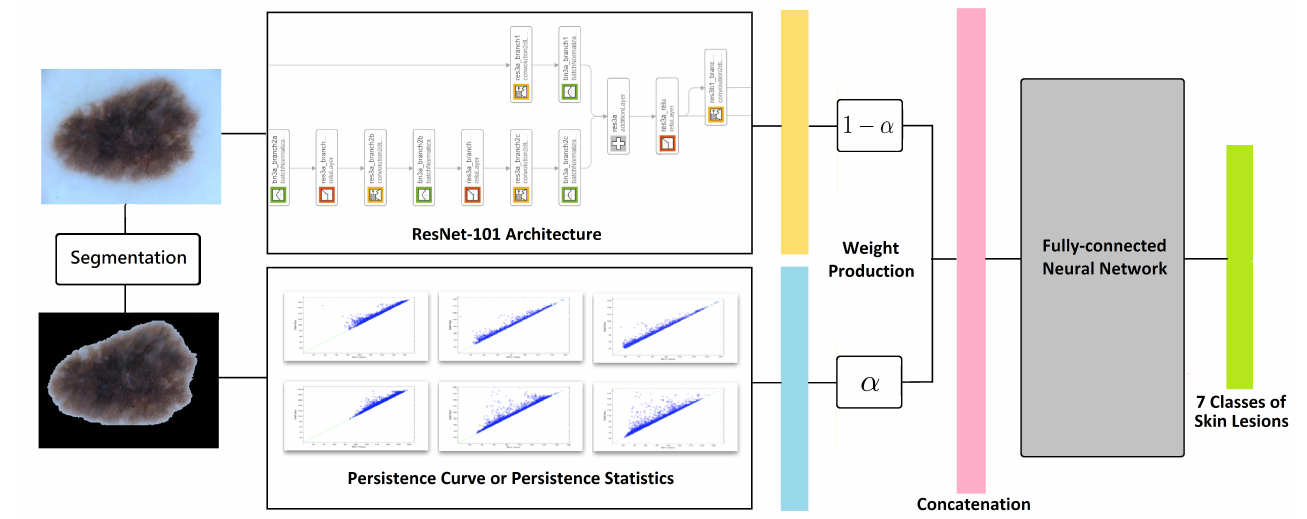
Figure 1. The architecture of TopoResNet-101. The blue bar is the concatenation of the PS and PC topological data and α ∈ [ 0,1 ] is the topological rate. The yellow bar is the output vector of ResNet-101 before a final fully-connected layer. The part of ResNet-101 architecture used in this figure is generated by the Deep Network Designer in the Matlab toolbox. Reproduced with permission from [32]; published by IEEE,